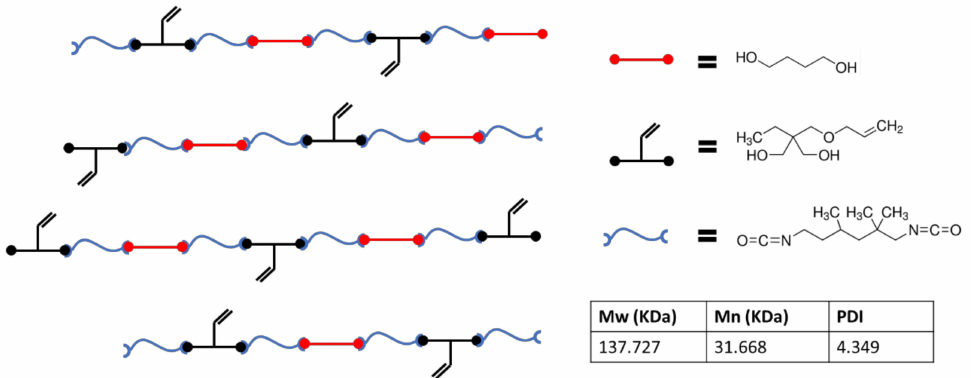
Figure 1. Schematic representing the thermoplastic polymer chemistry utilized during this study along with GPC data on the synthesized